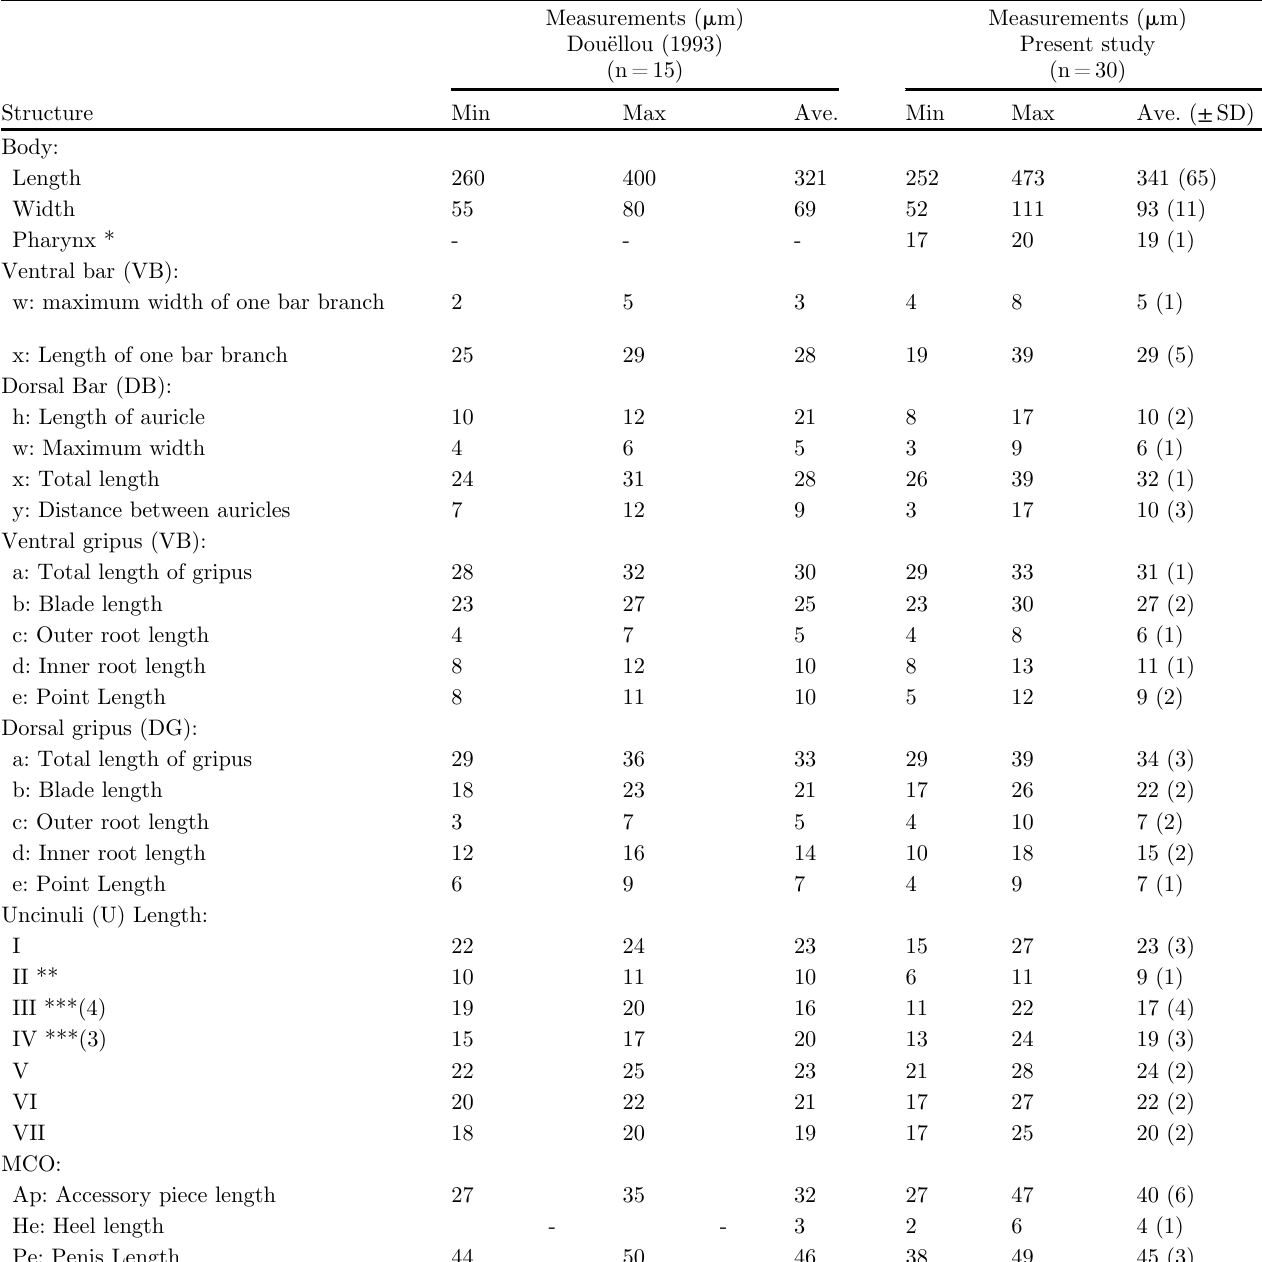
Table 1. Measurement (in m m) of Cichlidogyrus philander parasitic on Pseudocrenilabrus philander in Padda Dam, compared to measurements provided by Douëllou